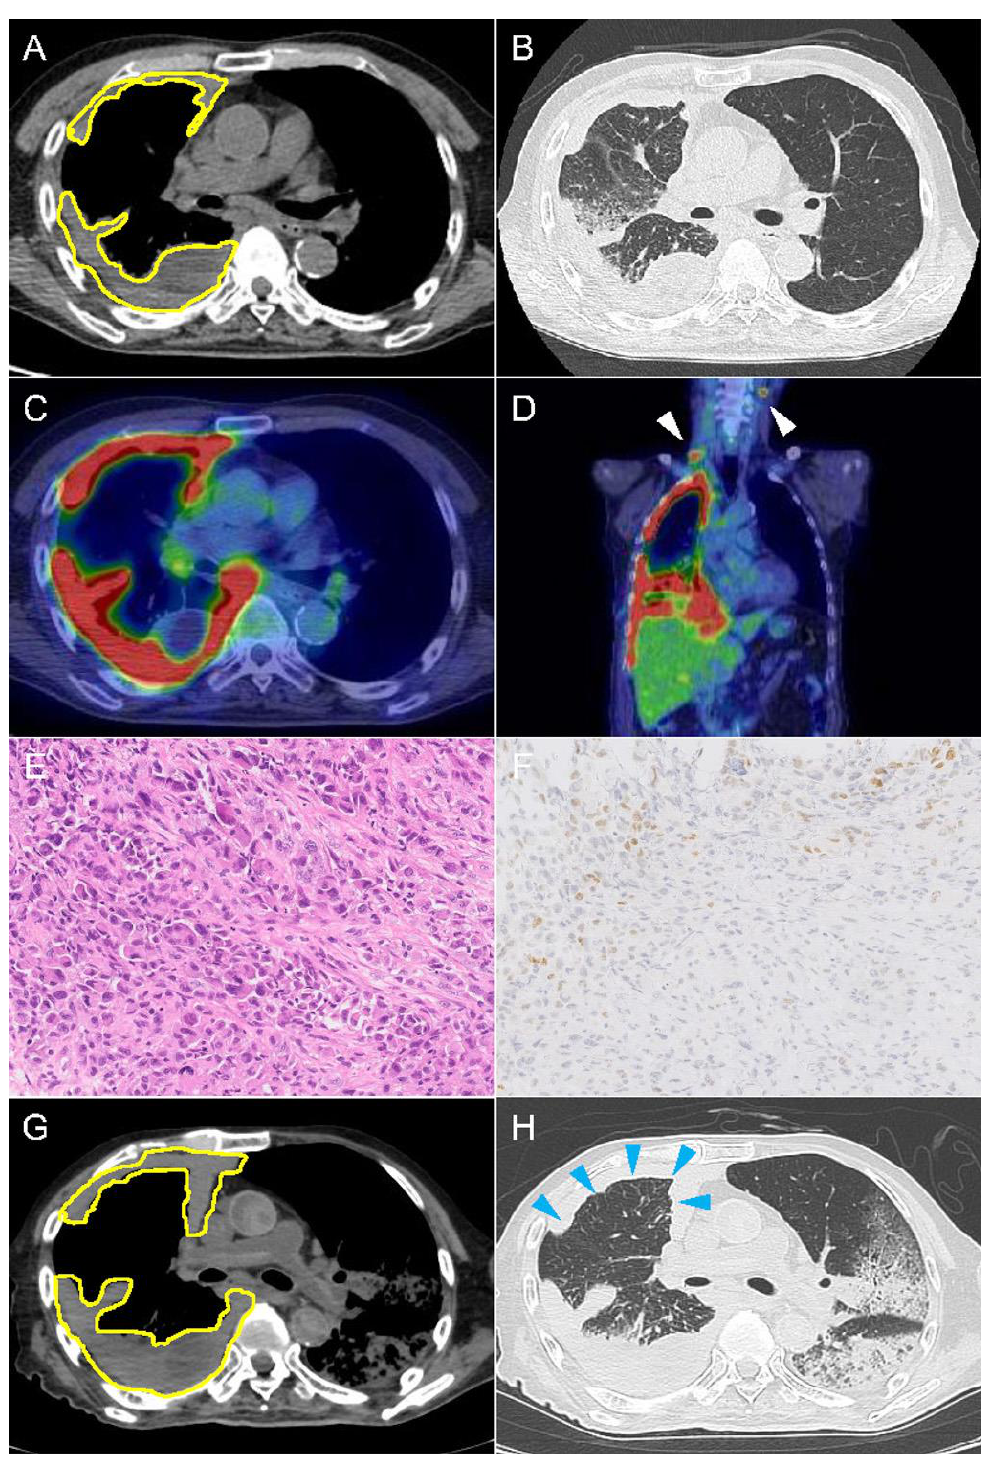
Figure 1. Imaging and histopathological findings in case 1. Chest computed tomography showing tumor (yellow outline) before ICI treatment on mediastinal ( A ) and lung ( B ) window images. PET-CT scan found high FDG uptake in the thickened right pleura ( C ), mediastinal and cervical lymph nodes ( D , white arrowhead). Hematoxylin & eosin staining revealed poorly differentiated carcinoma, 200× ( E ). Immunostaining with TTF-1 demonstrated only focal residual expression, 200× ( F ). Postmortem chest tomography showed significantly increased circumferential pleural thickness (blue arrowhead) on mediastinal ( G ) and lung ( H ) window images.